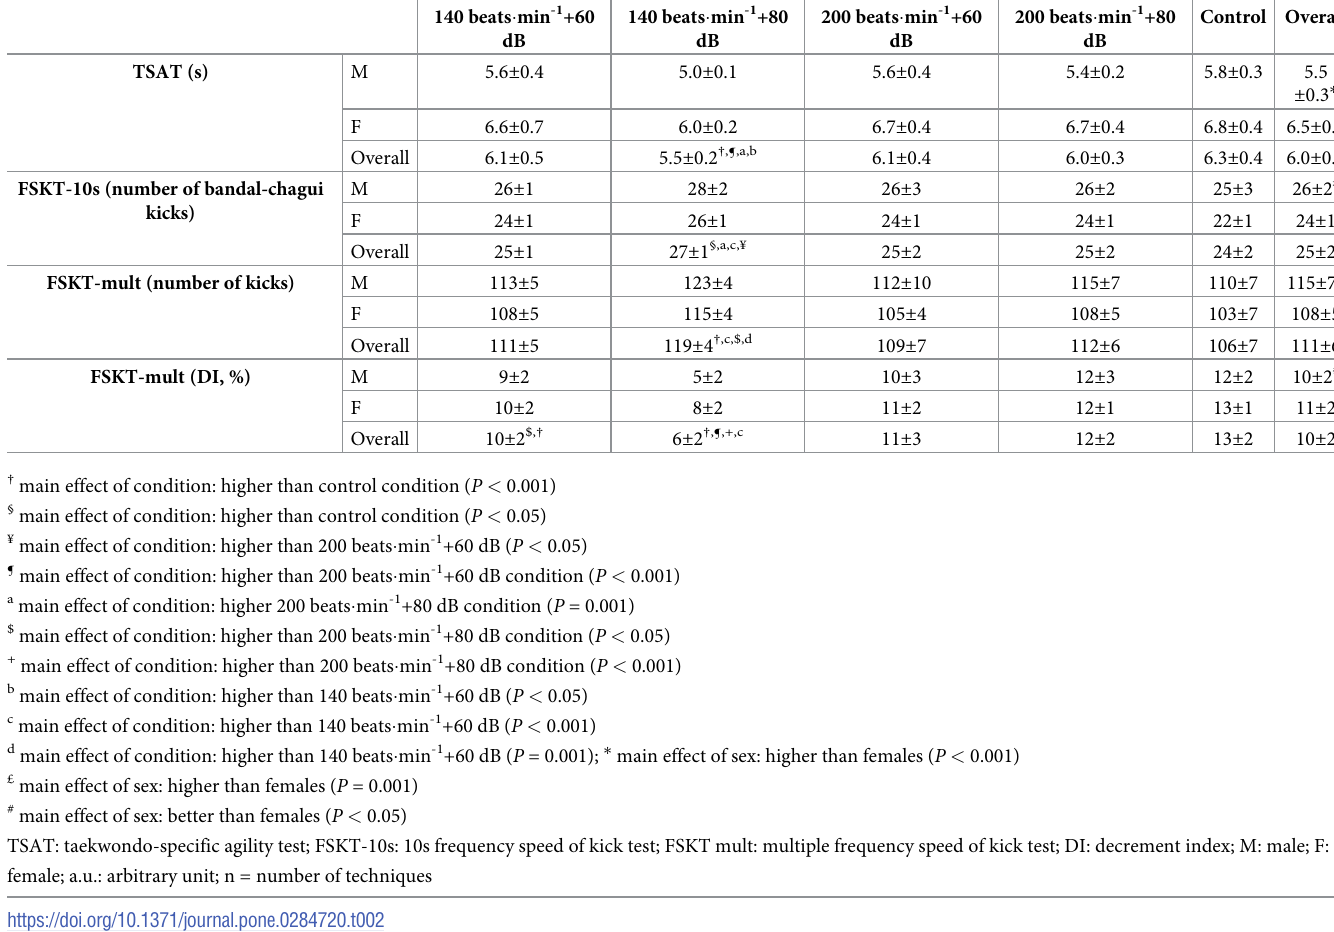
performance compared to females (95% CI = 4.392 to 9.288; d = 1.16; P < 0.001). However, there was no significant interaction effect between condition and sex ( F = 0.2; P = 0.954; η p2 = 0.01). 4,90 Decrement index. There was a significant main effect of condition ( F = 26.1; P < 0.001; 4,90 η p2 = 0.54), with 140 beats � min -1 +80 dB condition inducing lower DI compared with the 200 beats � min -1 +60 dB (95% CI = -6.495 to -2.466; d = -2.03; P < 0.001), 200 beats � min -1 +80 dB (95% CI [%] = -7.77 to -3.741; d = -3.02; P < 0.001), 140 beats � min -1 +60 dB (95% CI = -5.278 to -1.249; d = -1.56; P < 0.001) and the control (95% CI = -8.408 to -4.378; d = -1.57; P < 0.001) conditions (Table 2). Moreover, 140 beats � min -1 +60 dB condition resulted in lower DI com- pared to 200 beats � min -1 +80 dB (95% CI = -4.506 to -0.477; d = -1.13; P = 0.006) and control (95% CI = -5.144 to -1.115; d = -1.43; P < 0.001) conditions. Similarly, a significant main effect of sex was reported ( F = 8.2; P = 0.005; η p2 = 0.08), with lower DI in males than in females 1,90 (95% CI = -2.147 to -0.388; d = -0.59; P = 0.005). However, no significant interaction effect between condition and sex was found ( F = 0.8; P = 0.524; η p2 = 0.04). 4,90 Ratings of perceived exertion. For TSAT, there was no significant main effect of condi- tion ( F = 0.4; P = 0.053; η p2 = 0.75), sex ( F = 0.0; P = 0.95; η p2 = 0.00) or interaction 4,6 1,9 between condition and sex ( F = 2.5; P = 0.156; η p2 = 0.62; Table 3). For FSKT-10s, there was 4,6 no significant main effect of condition ( F = 4.4; P = 0.808; η p2 = 0.21). However, there was a 4,6